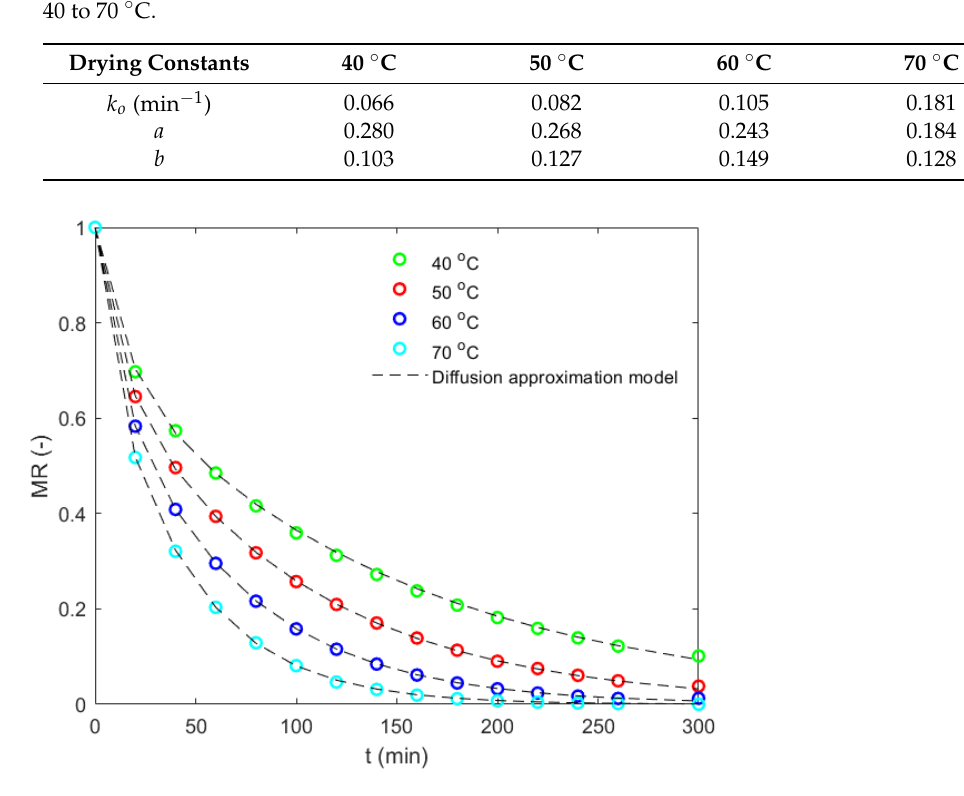
Figure 8. The computational drying kinetics of the CCN51 cocoa bean at the constant drying temperatures of 40, 50, 60, and 70 °C. A diffusion approximation model is fitted to the moisture ratio with the drying time.